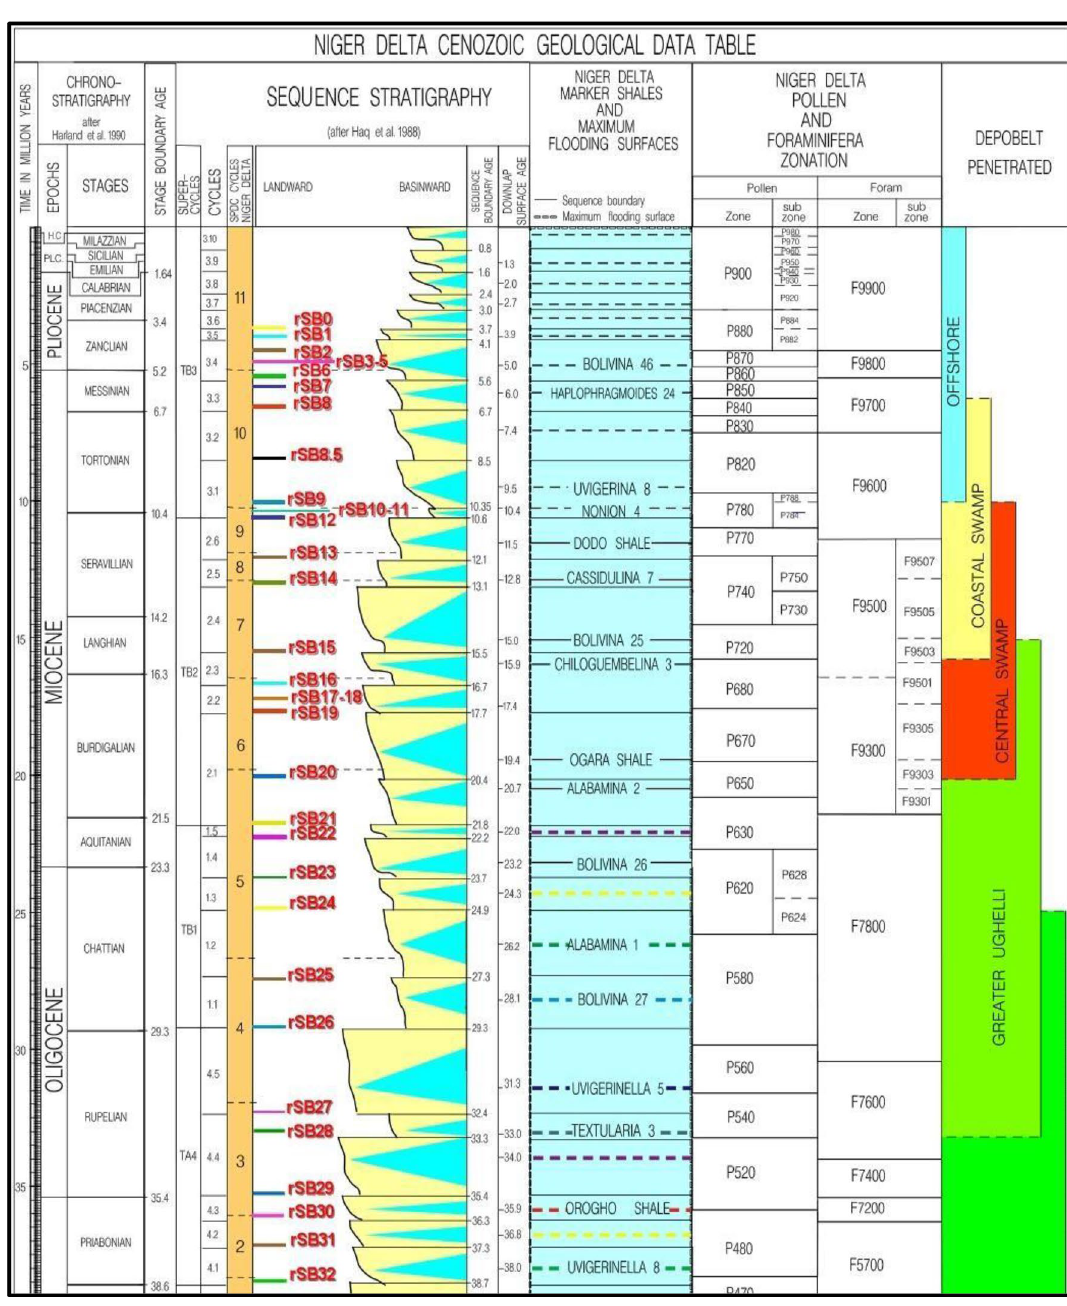
Fig. 5 Niger Delta Cenozoic chronostratigraphic chart (after Haq et al.